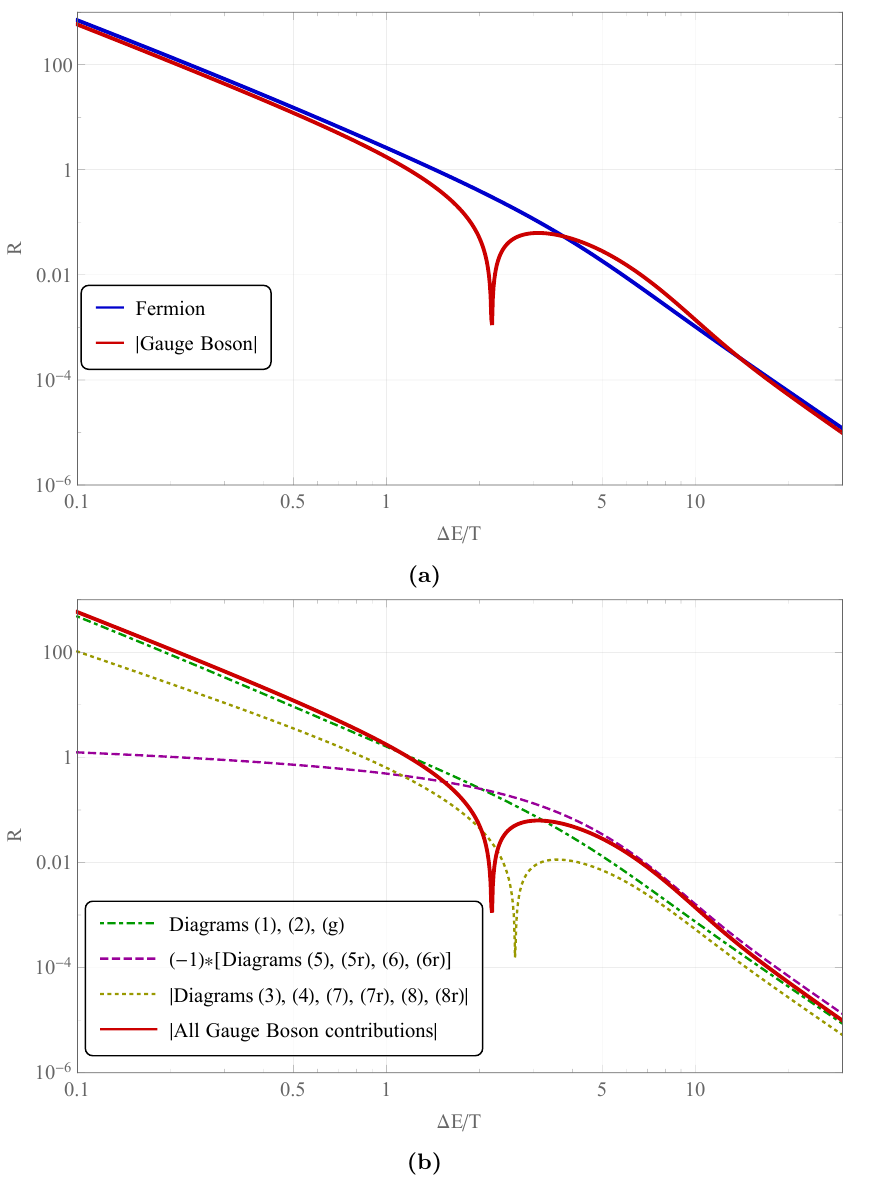
Figure 8. Finite temperature parts of the R functions. In (a), the blue curve corresponds to the fermion loop contribution eq. (4.5), in agreement with ref. [55], and the red solid line depicts the gauge sector contribution eq. (4.6), which includes contributions from all diagrams except diagram ( f ) . R T 6 =0 g is positive in the high temperature regime, changes the sign at the dip and becomes negative in the low temperature regime, whereas R T 6 =0 is always positive. However, we note that f the full LO + NLO contribution to the rates, including the vacuum contributions, stays positive. In (b), the non-vanishing finite temperature contributions from different diagrams are shown in dashed lines, each of which can be gauge-dependent. Only the sum, plotted as the red solid curve, is gauge